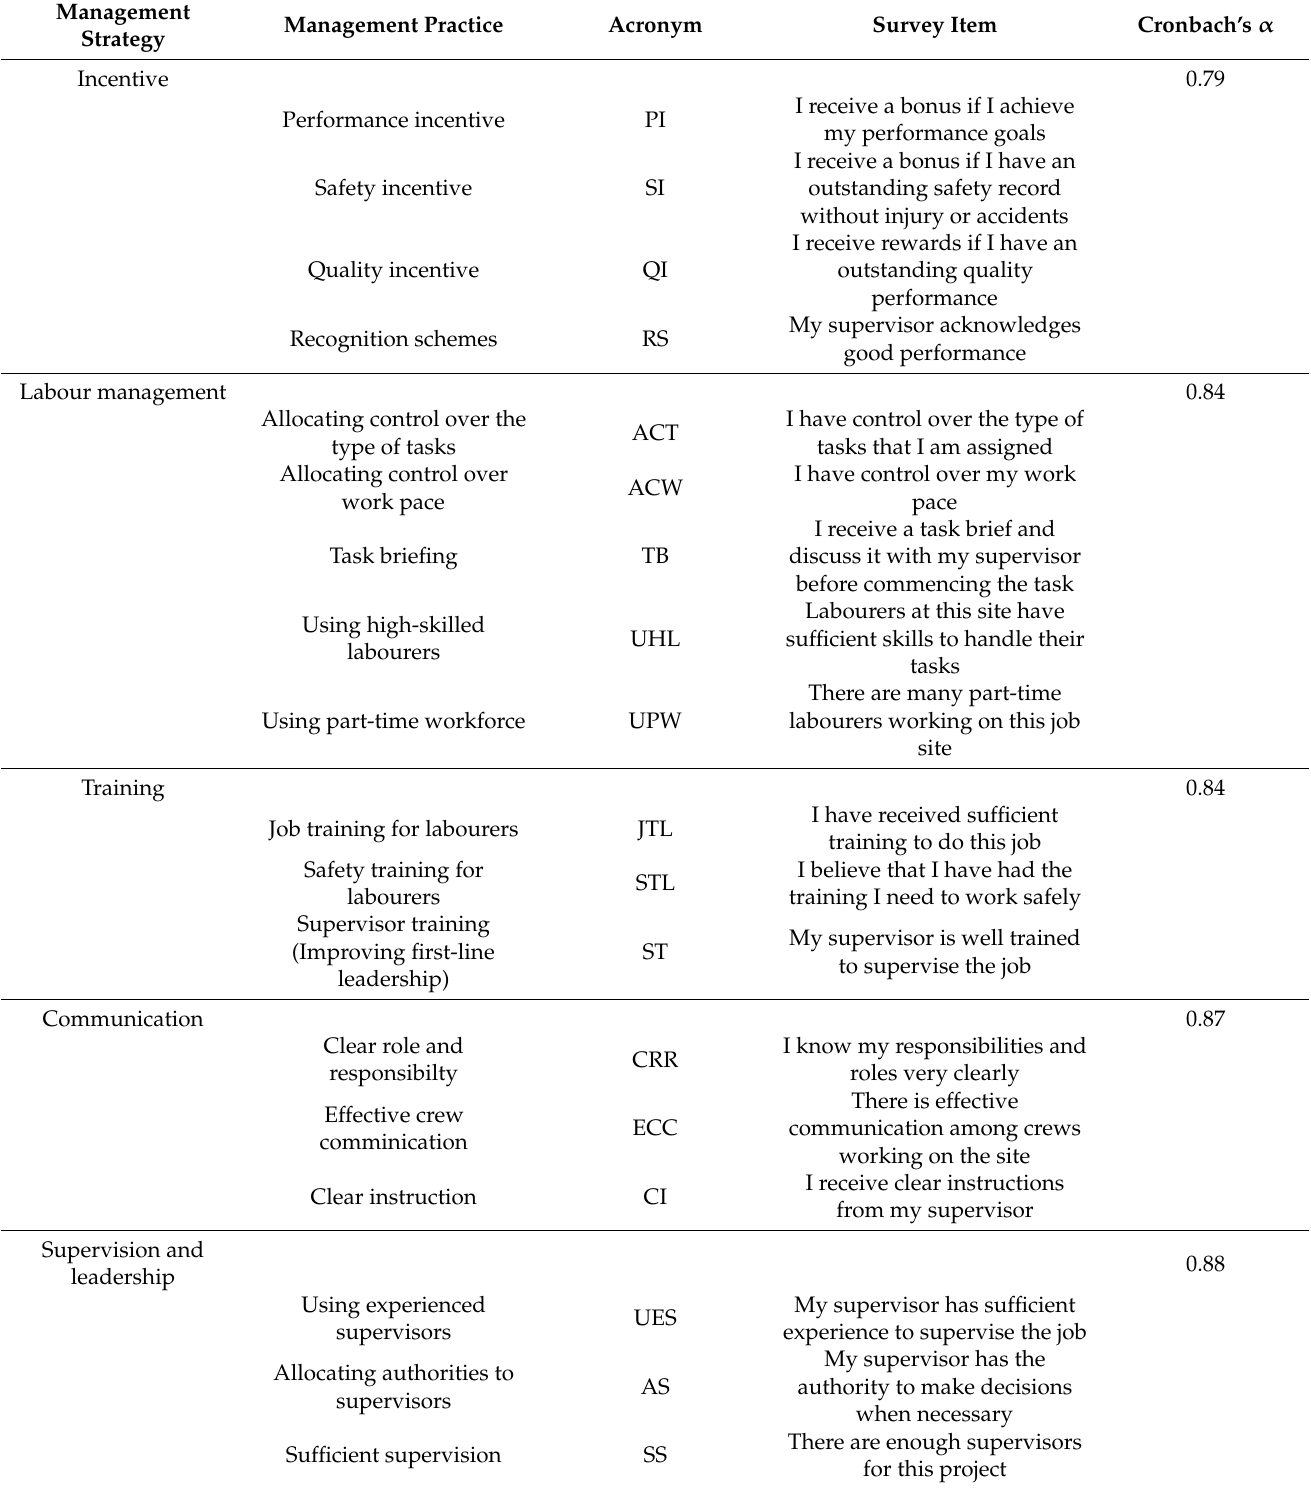
Table 1. Management strategies and practices based on modified